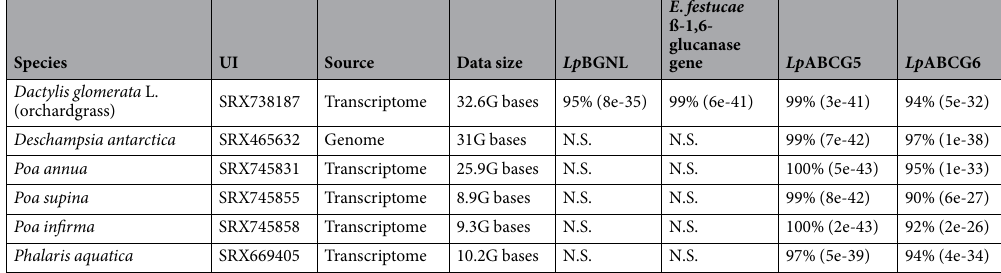
Table 3. Database search result using NCBI BLASTN suite. The sequence identity (%) and expect (E) value of the top matching sequence are